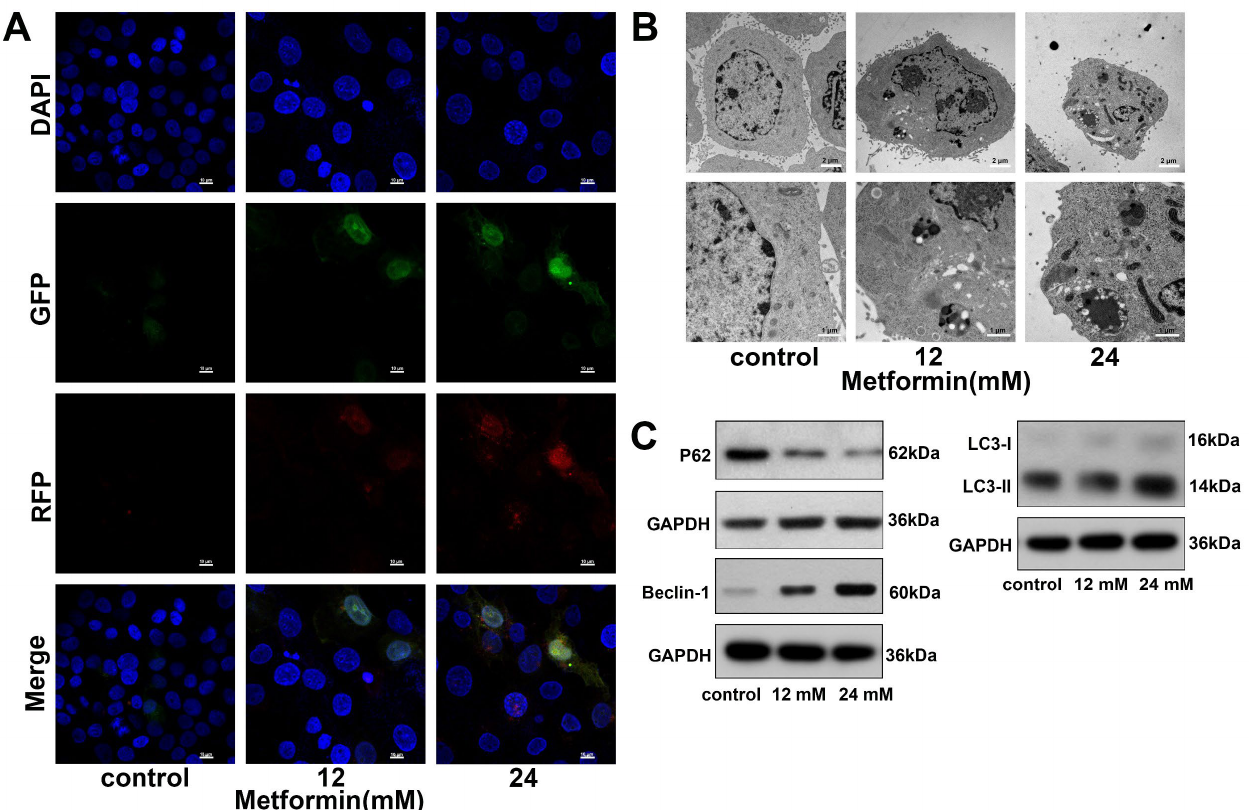
Figure 5. Metformin promoted autophagy in OSCC cells. ( A ). CAL27 cells were treated with various concentrations of metformin for 48 h. Meanwhile, the mRFP-GFP-LC3 adenovirus was used to detect the autophagic flux in CAL27 cells. The yellow dots (RFP+GFP+) were autophagosomes, whereas the red dots were (RFP+GFP-) were autolysosomes. The magnification = 1000×, scale bars = 10 μm ( B ). The autophagosomes and nucleus were observed by the TEM. CAL27 cells were treated with different concentrations of metformin for 48 h. Scale bars = 2 μm and 1 μm ( C ). CAL27 cells were treated with different concentrations of metformin for 48 h, and the autophagy-related proteins were analyzed by western blot. Original blots see Supplementary Figure S4. GAPDH was used as the internal reference protein.